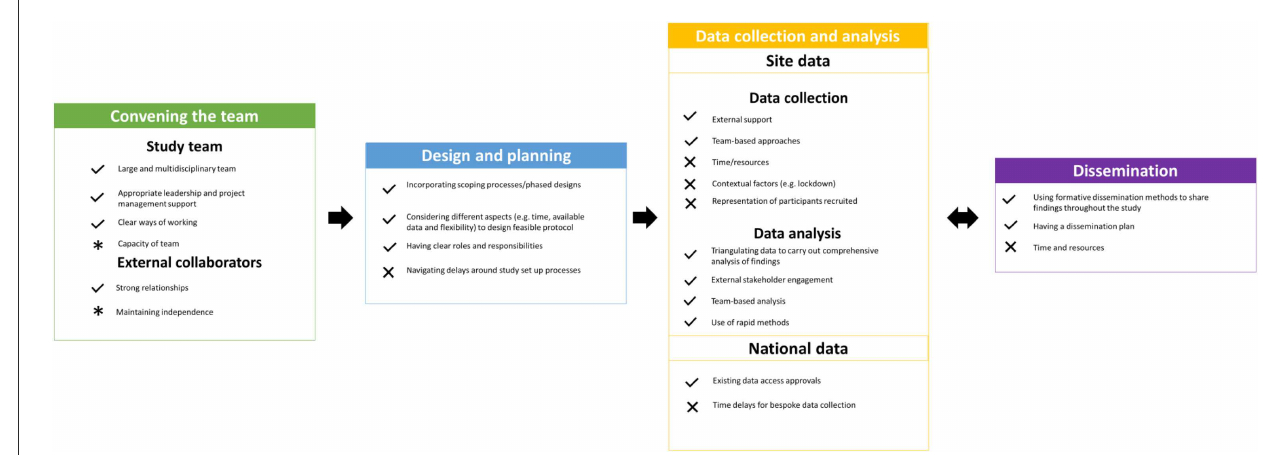
FIGURE1 A summary of the things that worked well (denoted by ticks) and challenges (denoted by crosses) when conducting these rapid evaluations. Note: Some aspects were identified as both strengths and challenges [denoted by asterisks (*)]. For example, capacity of the team was both a strength (having a number of researchers providing a percentage of their time to the evaluation meant that we had a larger team) and a challenge (due to having a large number of team members, it was difficult to anticipate how much time each member of the team was needed for the